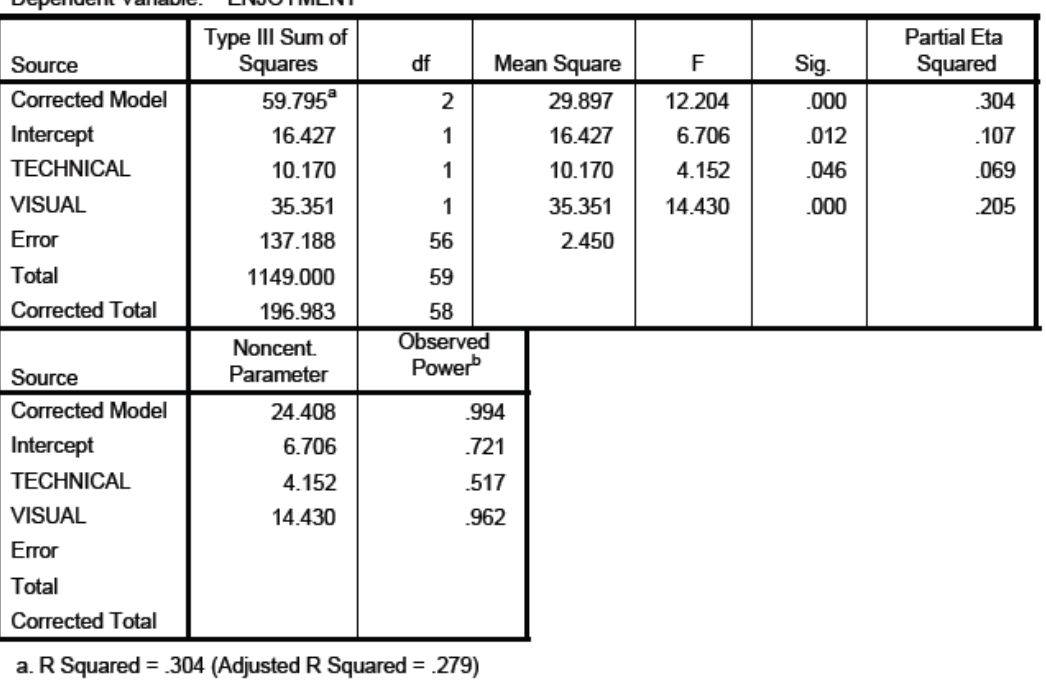
Figure B.22. ANCOVA analysing enjoyment levels in regard to visual preference using data adjusted for technical